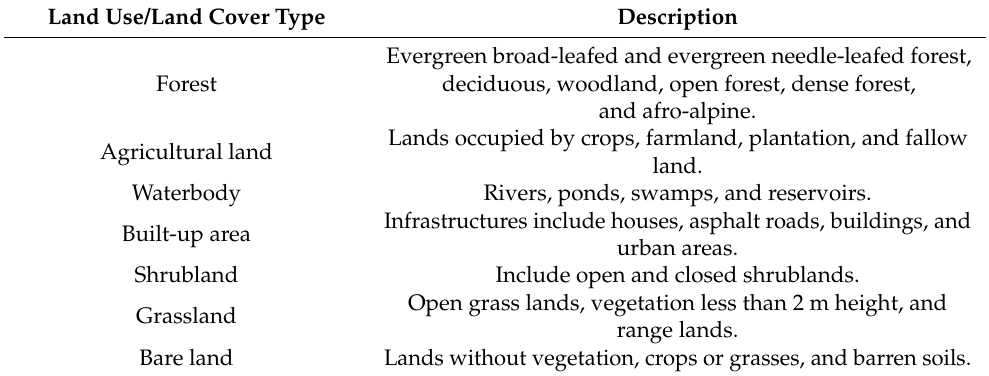
Table 2. LULC classes and description. Land Use/Land Cover Type Description Evergreen broad-leafed and evergreen needle-leafed forest, Forest deciduous, woodland, open forest, dense forest, and afro-alpine. Lands occupied by crops, farmland, plantation, and fallow Agricultural land land. Waterbody Rivers, ponds, swamps, and reservoirs. Infrastructures include houses, asphalt roads, buildings, and Built-up area urban areas. Shrubland Include open and closed shrublands. Open grass lands, vegetation less than 2 m height, and Grassland range lands. Bare land Lands without vegetation, crops or grasses, and barren